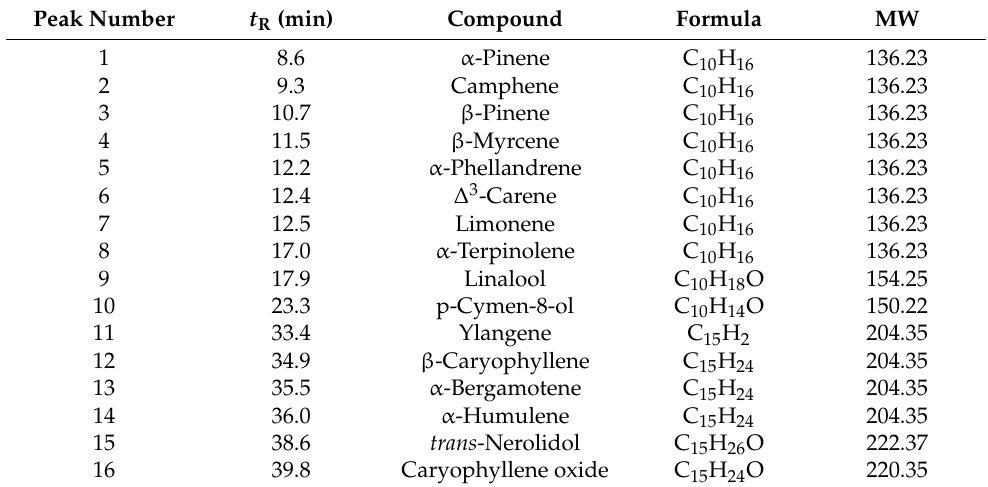
Figure 2. Representative GC-MS selected ion monitoring (SIM) chromatogram of hemp oil 2 (K2), obtained by monitoring the ion at 93 m / z . It is possible to see the peak of the internal standard (I.S.). Fatty acids (F.A.) from olive oil, used as the extraction solvent, eluted among the terpenes of interest. For peak identification, see Table 3. Table 3. Retention time, molecular formula, and molecular weight of the compounds identified in hemp oils by GC-MS.